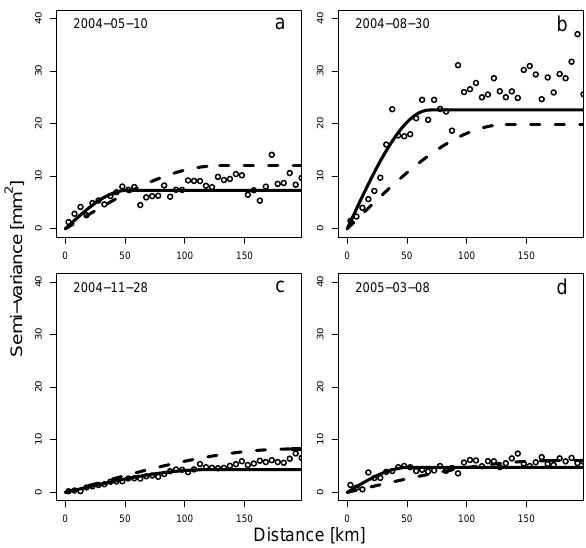
Fig. 11. Example of fitted semi-variograms for four days between March 2004 and March 2005. The solid line is the fitted variogram and the dashed line is the climatological